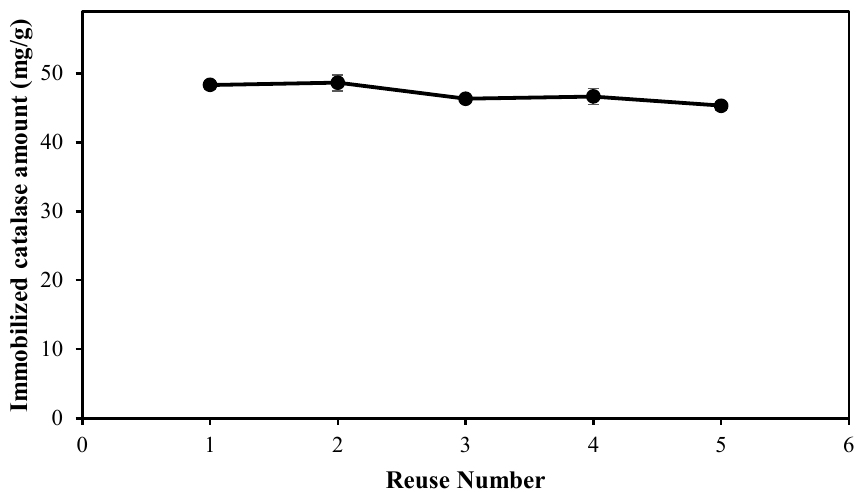
Figure 8. Reusability of p(HEMA-co-AGE) cryogel [flow rate: 1.0 mL/min; catalase concentration: 1.0 mg/mL; T: 25 °C].